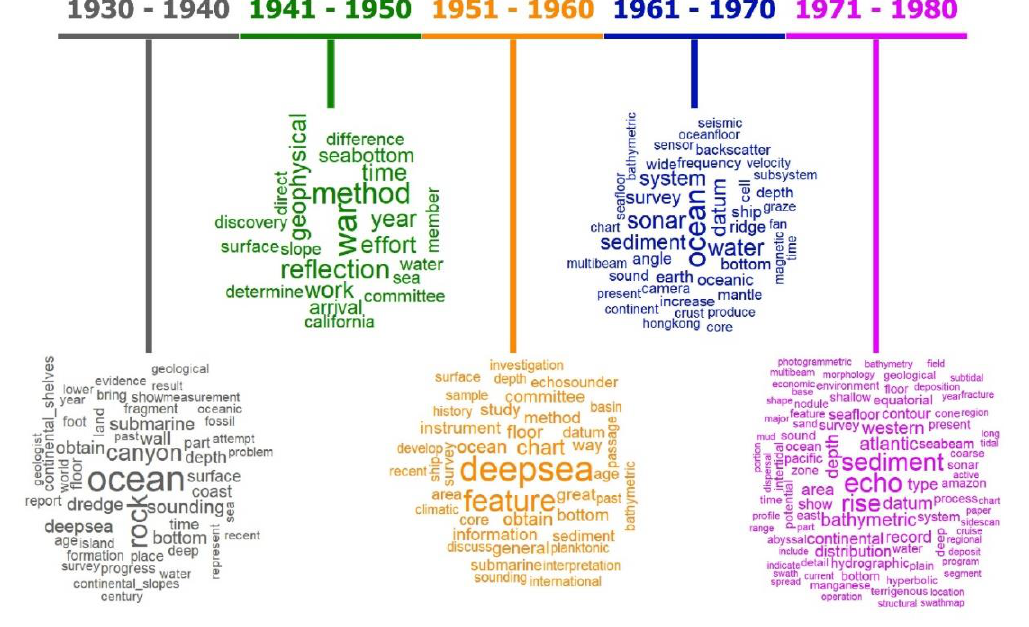
Figure 3. Word cloud for each decade (1930–1980).